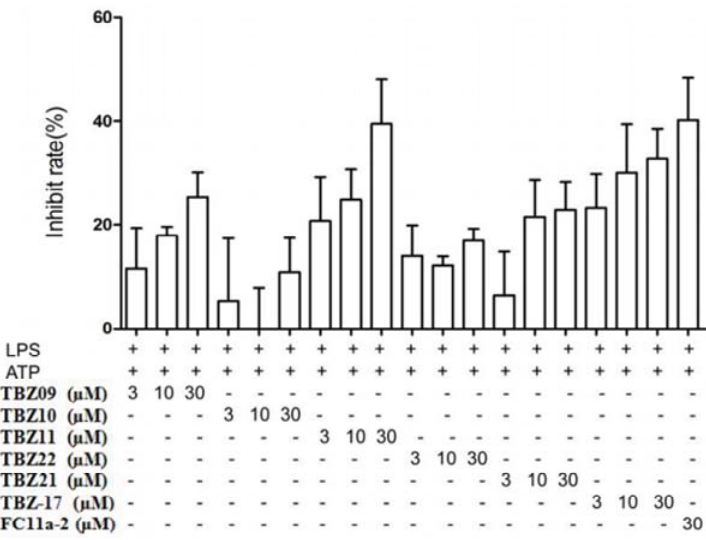
Figure 4. The effects of various doses of TBZ ‐ 09 , ‐ 10 , ‐ 11 , ‐ 17 , ‐ 21 , and ‐ 22 on IL ‐ 1 β productions in THP ‐ 1 cells activated by LPS plus ATP.